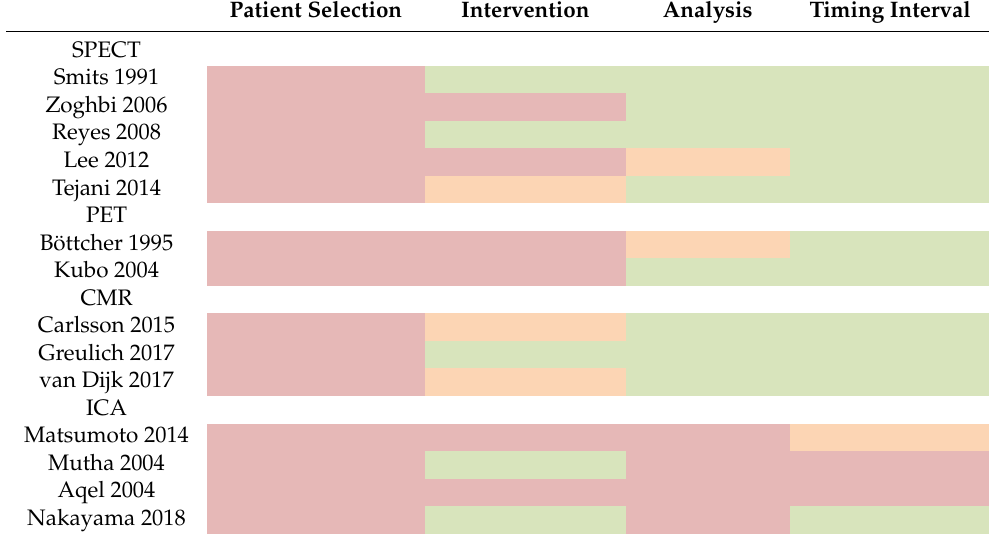
Table 3. Study quality assessment. Red: High, Low: Green, Orange: Unclear risk of either bias (patient selection bias, analysis bias) or applicability concerns (intervention and timing interval possibly not reflection of clinical